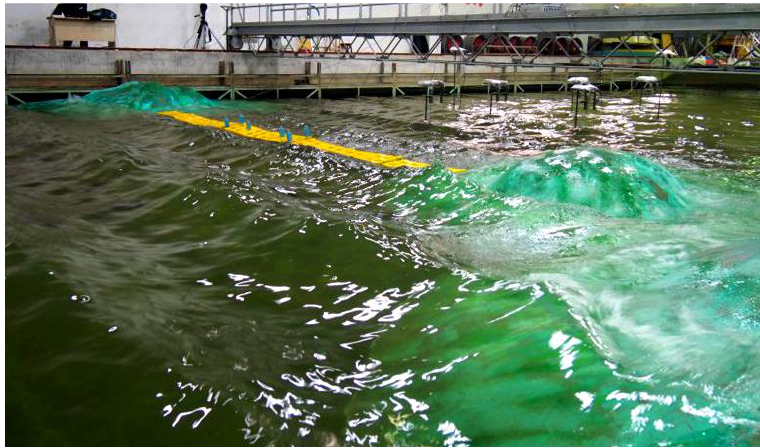
Figure 23. Wave aggregation effect.